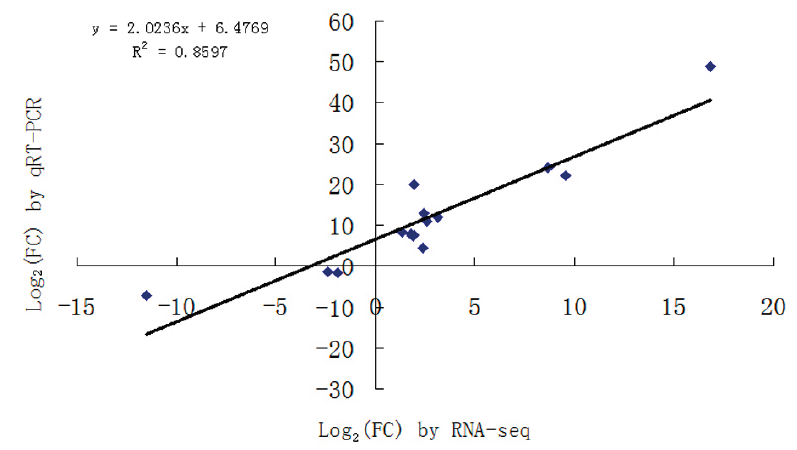
Figure 3. Comparison of log 2 (FC) of 15 selected transcripts using RNA-seq and